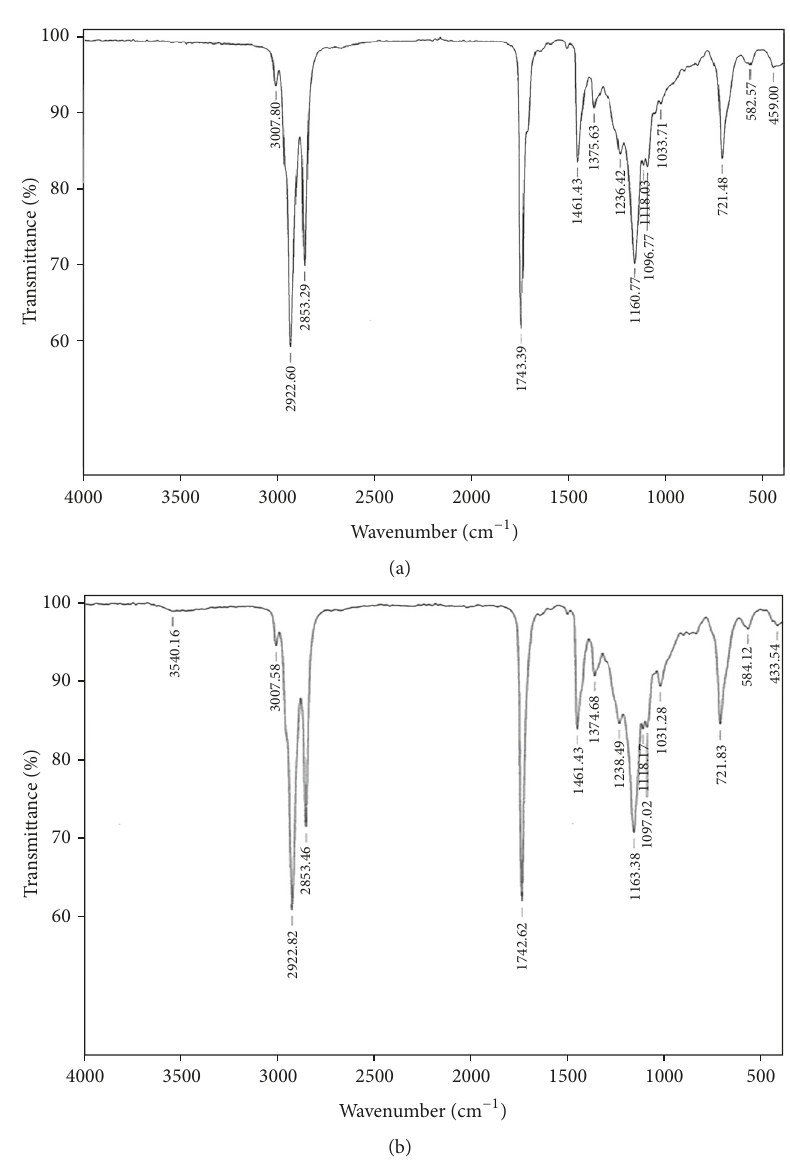
Figure 2: FTIR spectra of the esterification process: (a) 𝑡 = 0 min and (b) 𝑡 = 60